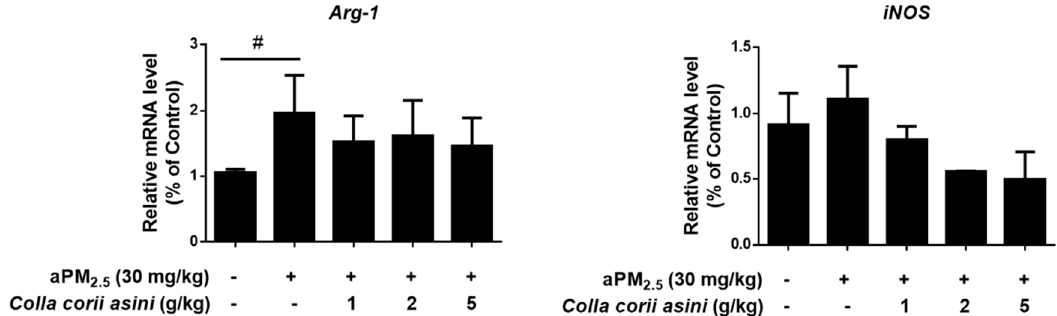
Figure 7. Effects of Colla corii asini on the relative gene expression of Arg-1 and iNOS in the lungs of rats subjected to intratracheal instillation of aPM 2.5 for 11 weeks. Values are reported using the 2 − ∆∆ C t method and were obtained by comparing with those of the control group and normalized to ACTB (mean ± SD, n = 3). # p < 0.05, versus the control group.